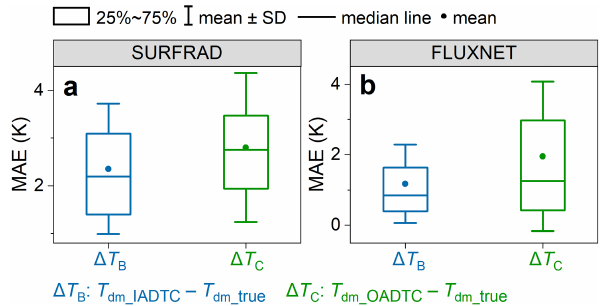
Figure B1. Box plots for the MAEs of the IADTC framework ( T dm_ATC_DTC ) and the OADTC framework ( T dm_OADTC ) under Scenarios no. 1 and no. 3. Panels (a) and (b) are for the SURFRAD and FLUXNET measurements,